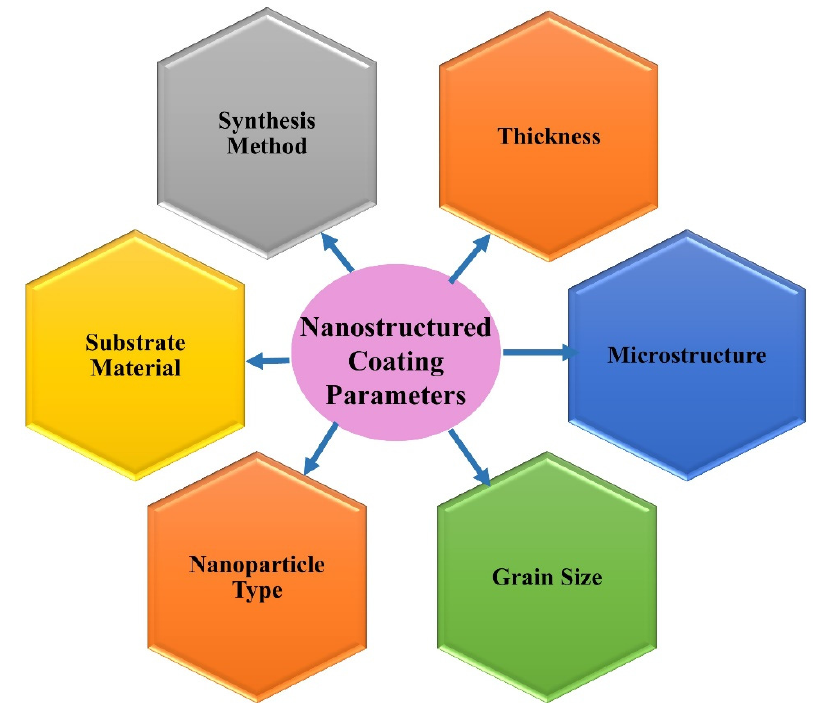
Figure 2. Various parameters influencing nanostructured coating formation. Table 1. Coating preparation methods and their process parameters.